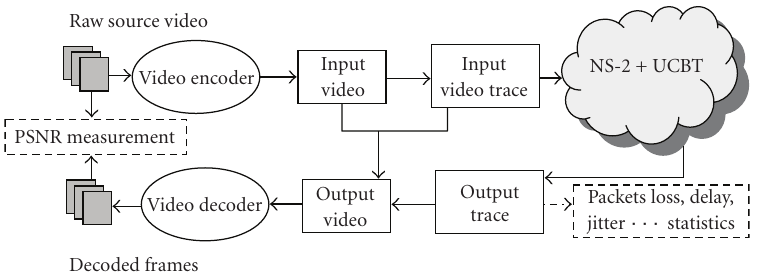
Figure 4: The testing environment for the experiments of Section 4.